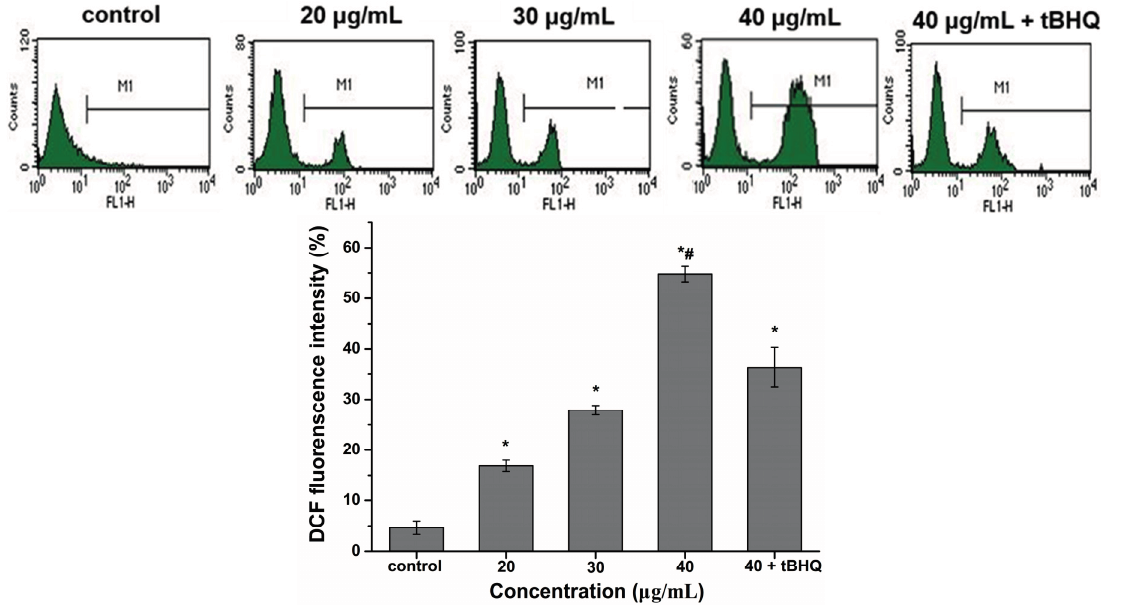
Figure 4. ROS generation in AML12 cells after 24 h of treatment with 20, 30, 40 μ g/mL CdTe QDs and (40 μ g/mL CdTe QDs + tBHQ). ROS formation was quantified by flow cytometry, and M1 represents the percentage of ROS production. Data are expressed as dichlorofluorescein (DCF) channel relative to that of untreated cells. The asterisks ( * )